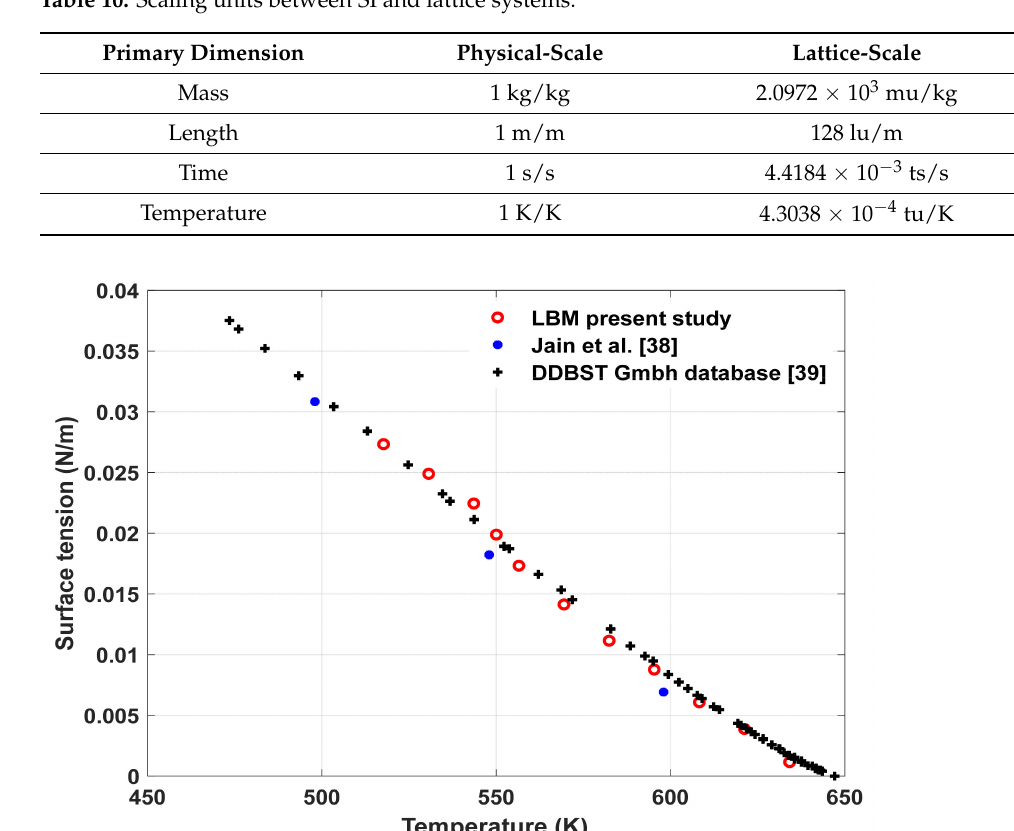
Figure 11. Comparison between the current work and previously published works for the surface tension of water as a function of